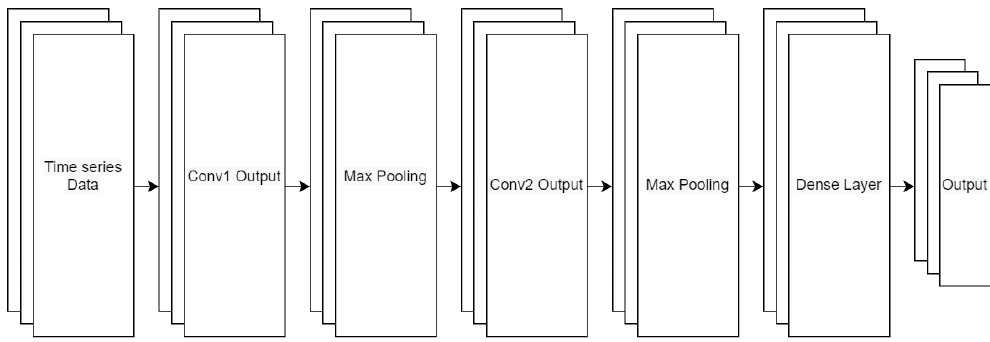
Figure 2. Anomaly Detection for Time